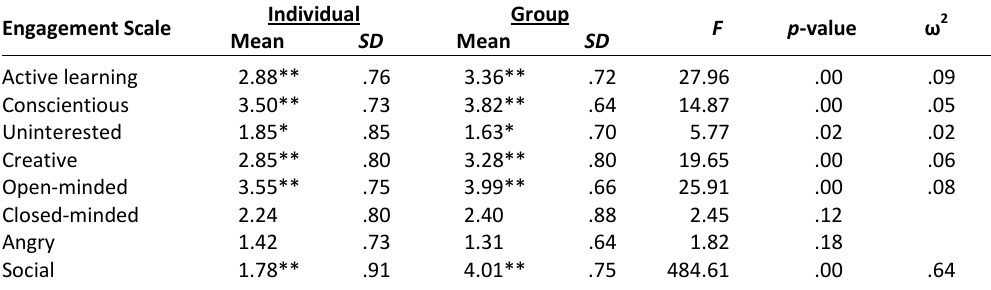
Table 5. Differences between Group and Individual Conditions (Study 1, Task 2) Individual Group Engagement Scale F p -value ω 2 Mean SD Mean SD Active learning 2.88** .76 3.36** .72 27.96 .00 .09 Conscientious 3.50** .73 3.82** .64 14.87 .00 .05 Uninterested 1.85* .85 1.63* .70 5.77 .02 .02 Creative 2.85** .80 3.28** .80 19.65 .00 .06 Open-minded 3.55** .75 3.99** .66 25.91 .00 .08 Closed-minded 2.24 .80 2.40 .88 2.45 .12 Angry 1.42 .73 1.31 .64 1.82 .18 Social 1.78** .91 4.01** .75 484.61 .00